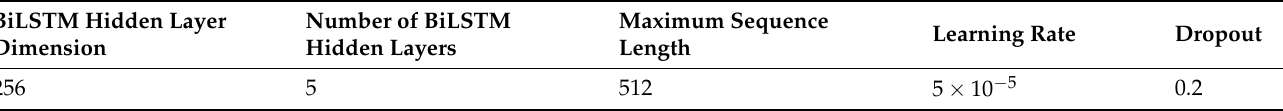
Table 3. Model parameter